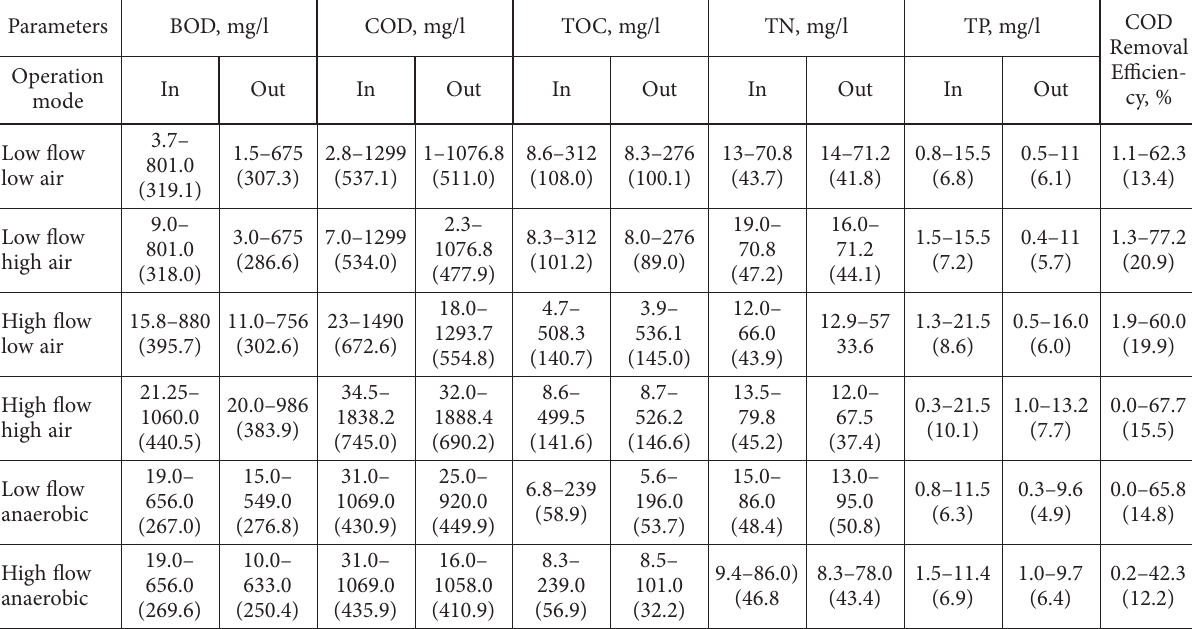
Table 2. Overview of process efficiency